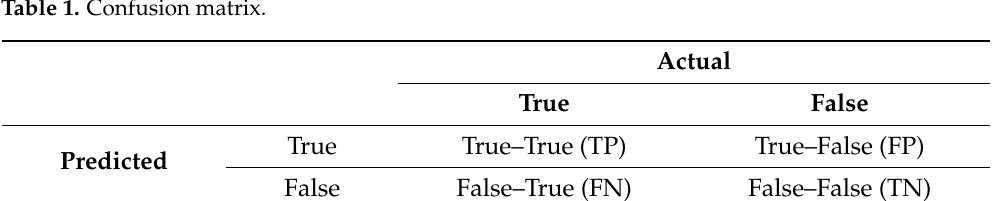
Table 1. Confusion matrix.